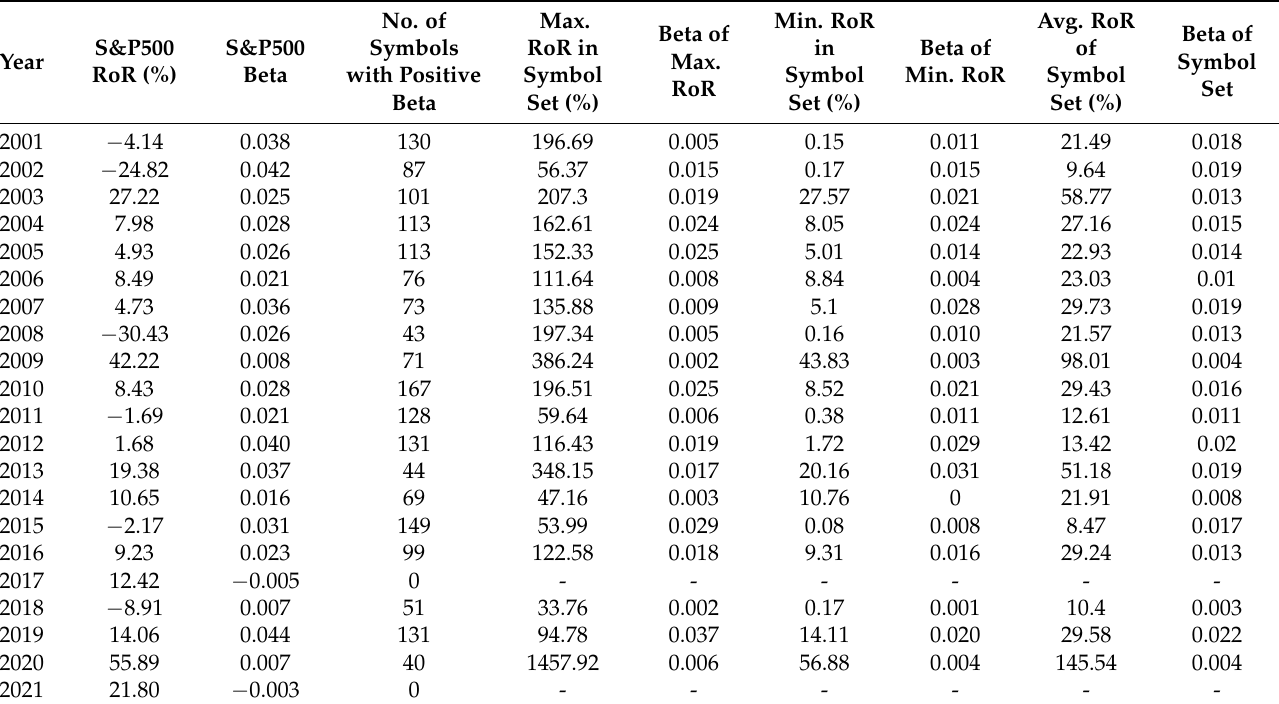
Table 3. Sets of NYSE symbols, selected annually, based on the rate of return (RoR) of the S&P500 index and its beta relative to the CSIE of the market as a whole. Only sets of stocks with positive beta relative to the market CSIE